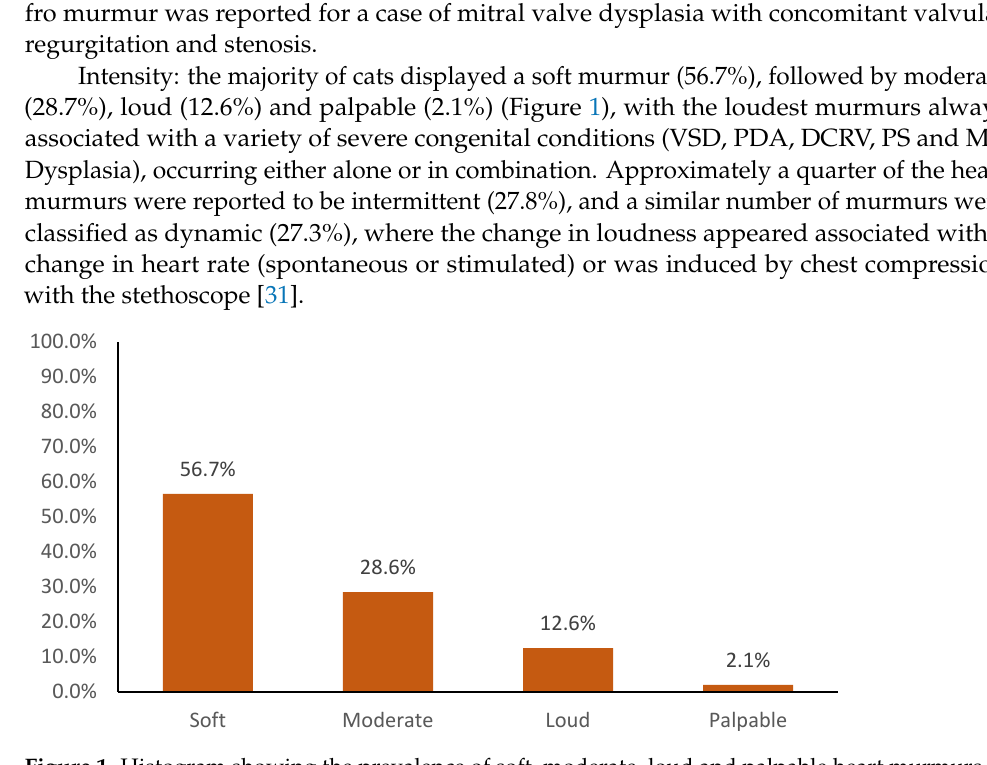
Figure 1. Histogram showing the prevalence of soft, moderate, loud and palpable heart murmurs in a population of 856 cats referred for diagnostic investigation of their murmur.